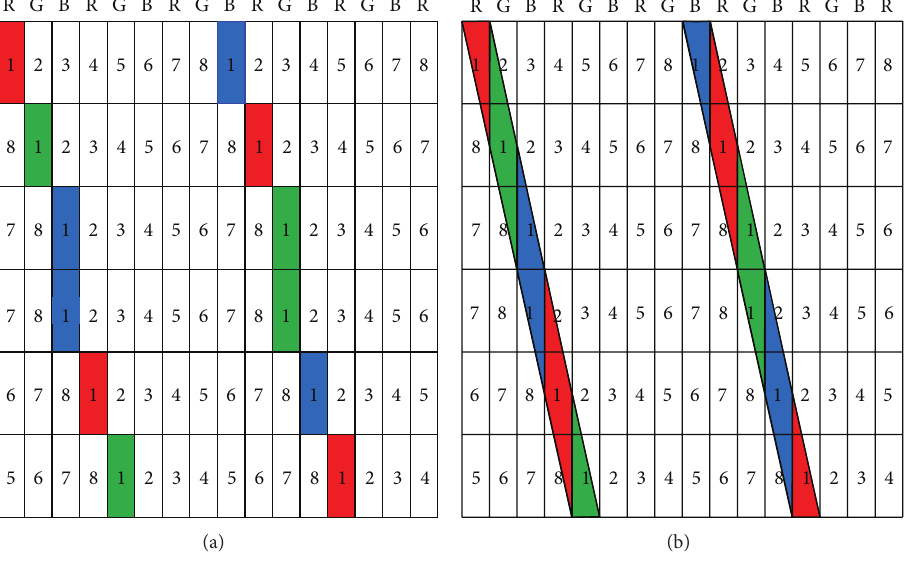
Figure 1: Structures of two kinds of multiview 3D displays. (a) A parallax barrier display. (b) A lenticular display. R RRRRRG GGGG BBB